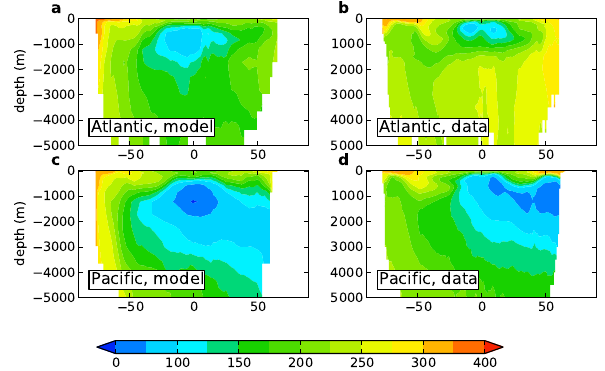
Figure 12. Zonal average of the oxygen distribution in the ocean (µmolkg − 1 ). Data from the World Ocean Atlas 2009 (Garcia et al.,